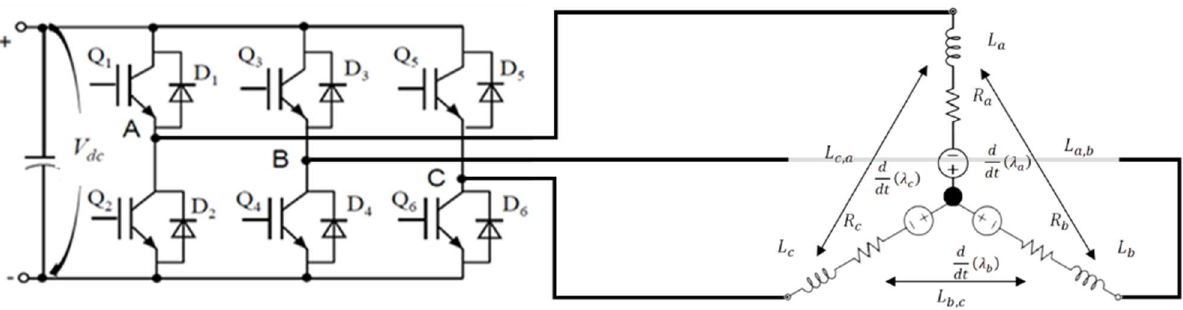
Figure 4. Schematics of the Electric-Drive model.